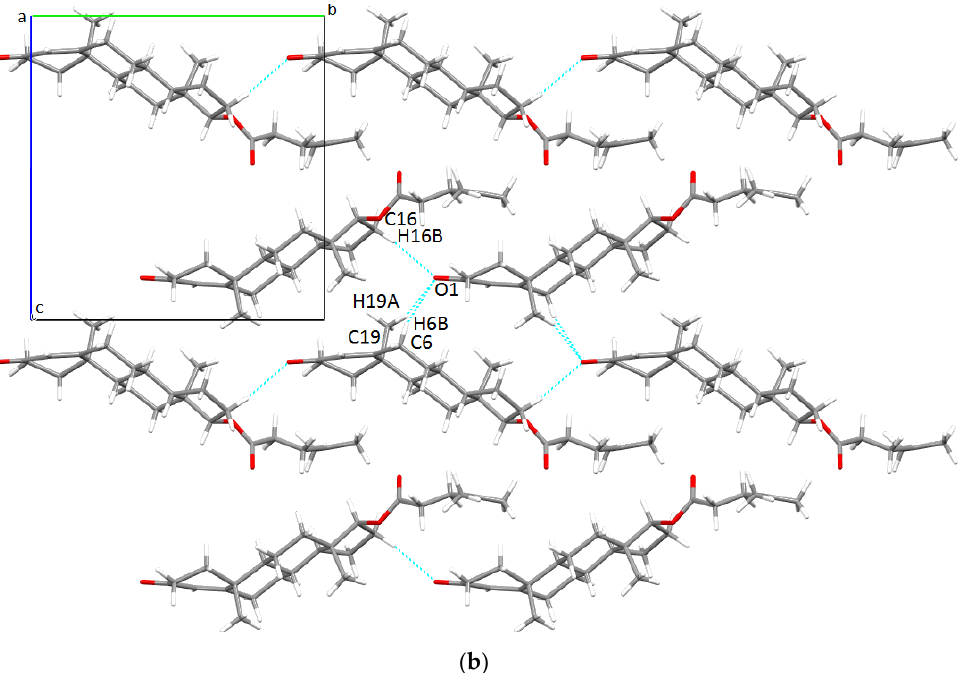
Figure 3 . Asymmetric unit of TIso presenting nonhydrogen atoms at 50% probability level ( a ) and overall packing diagram along a-axis ( b ) .